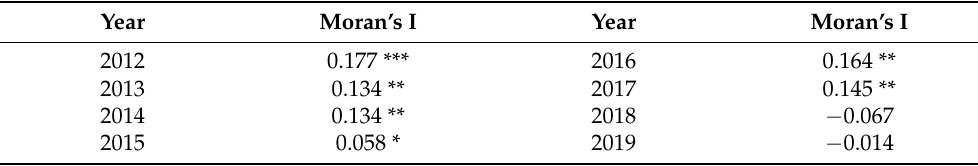
Table 4. Global Moran’s I of ecological well-being